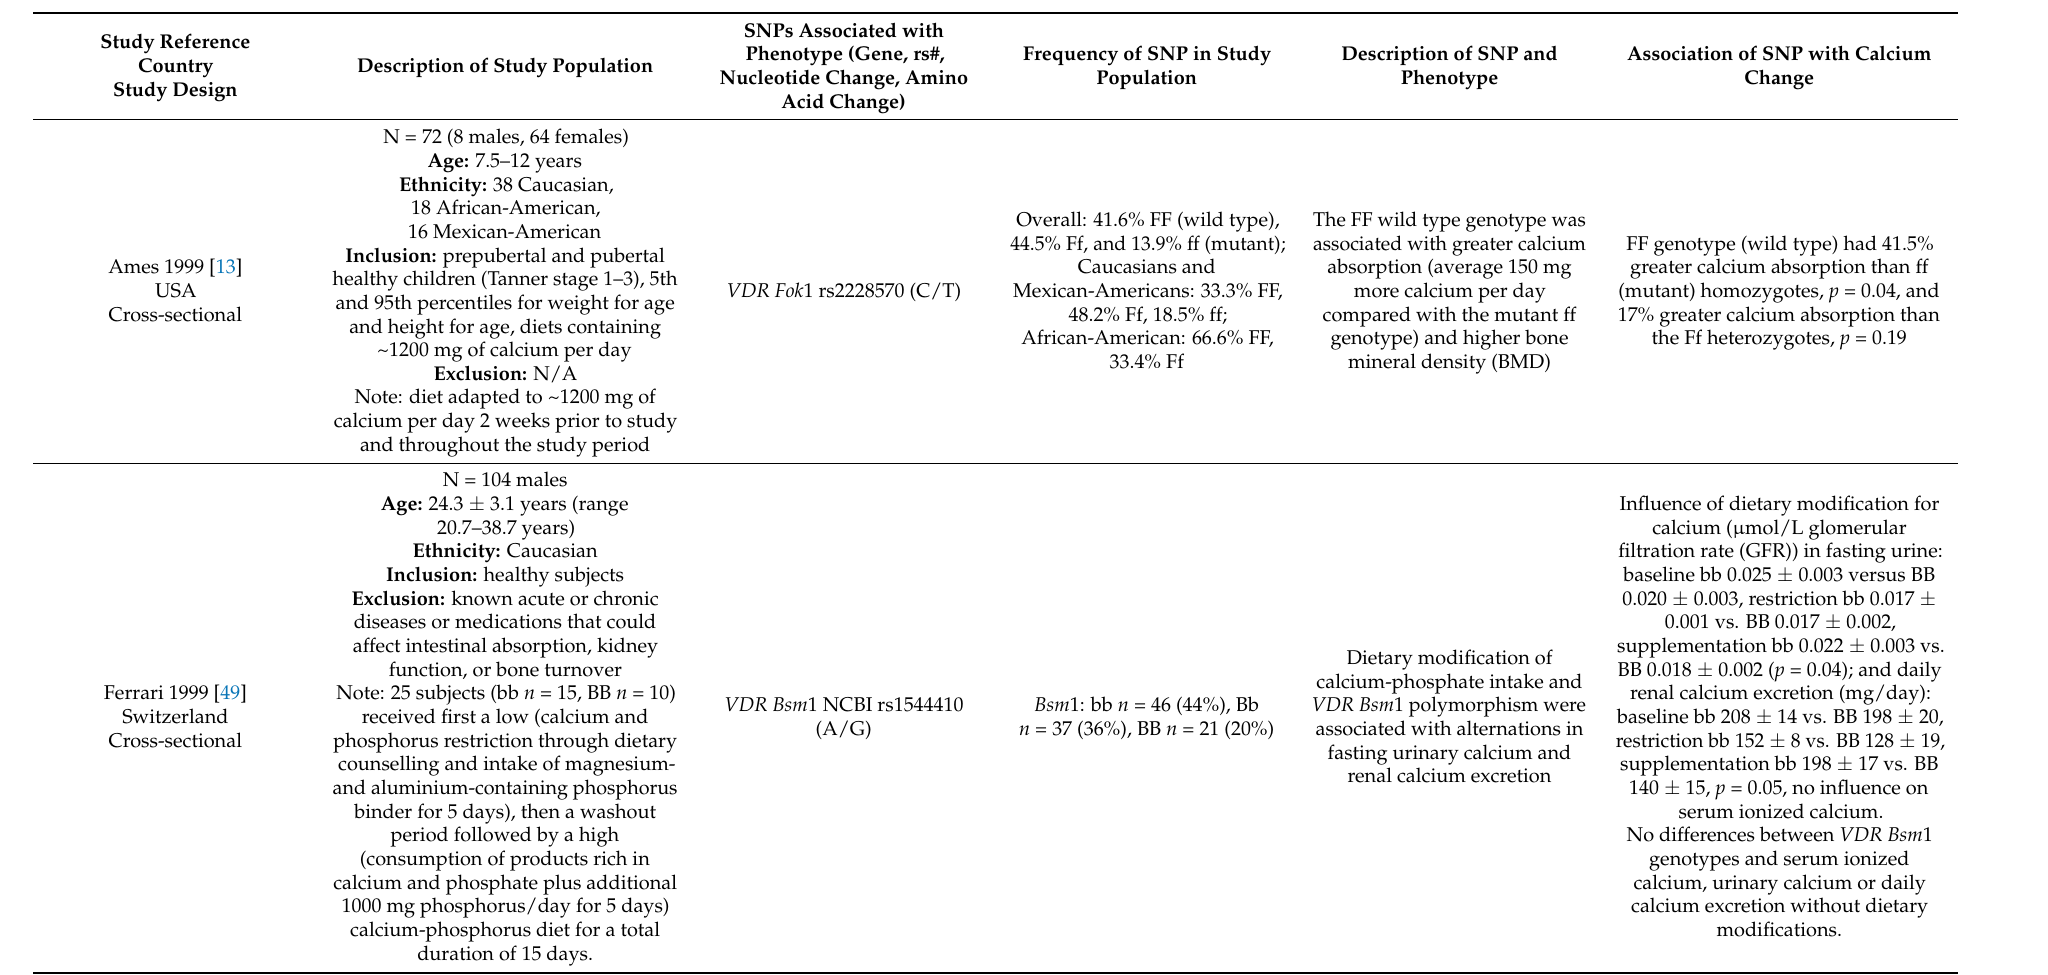
Table 3. Characteristics of studies assessing polymorphisms of the vitamin D receptor